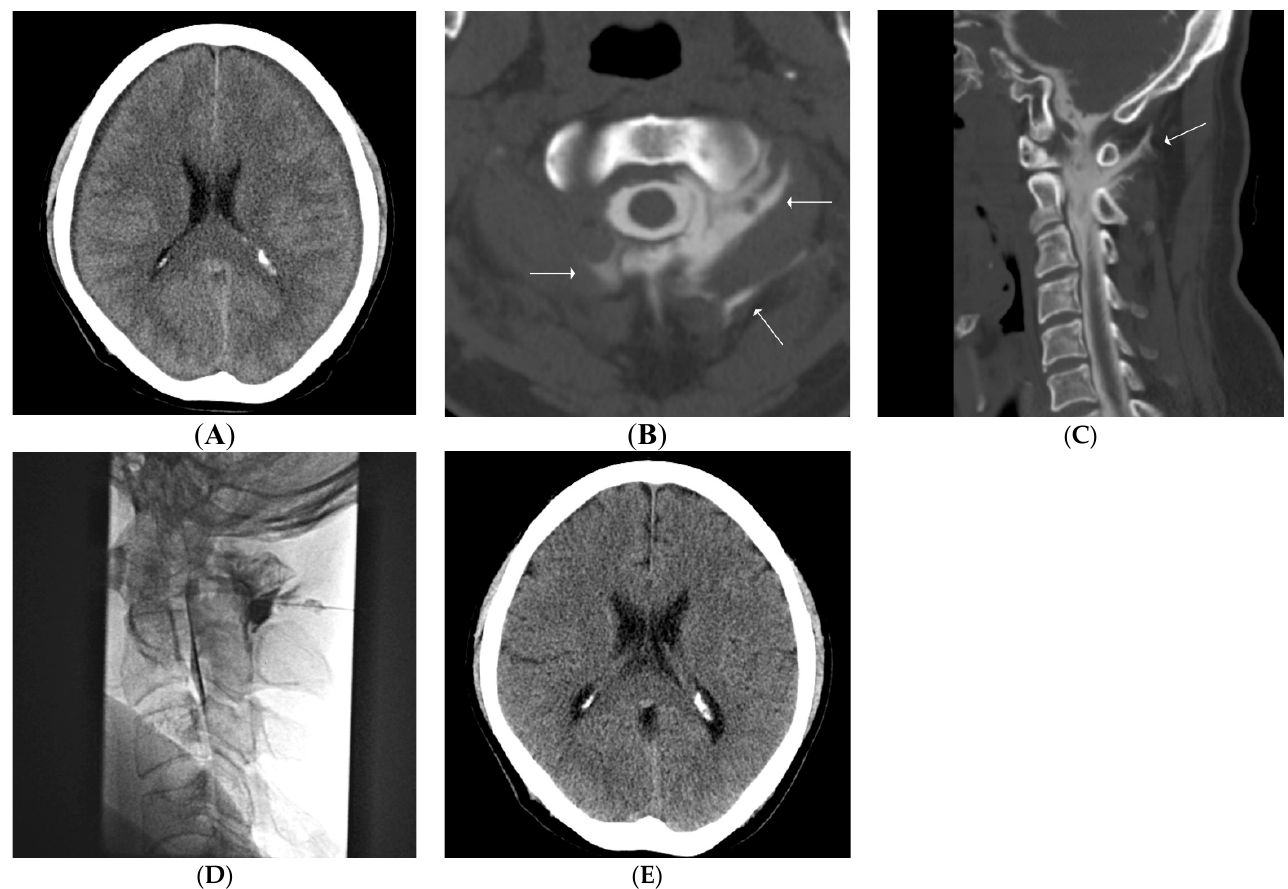
Figure 1. (A – E) Findings for a representative case involving a 53 ‐ year ‐ old man with nontraumatic intracranial subdural hematoma (SDH). The patient presented with a chief complaint of headache not related to a specific posture. ( A ). Brain computed tomography (CT) image shows bilateral intracranial SDH. He was referred to us for CT myelography and epidural blood patch (EBP) the day after undergoing burr ‐ hole trephination and hematoma removal. ( B , C ). Axial and sagittal CT myelography images show a large amount of cerebrospinal fluid leaks at the level of the C1/2 left extradural space (solid arrows). ( D ) EBP is performed at the C1/2 level. ( E ). Follow ‐ up brain CT performed after 3 months shows no evidence of SDH.